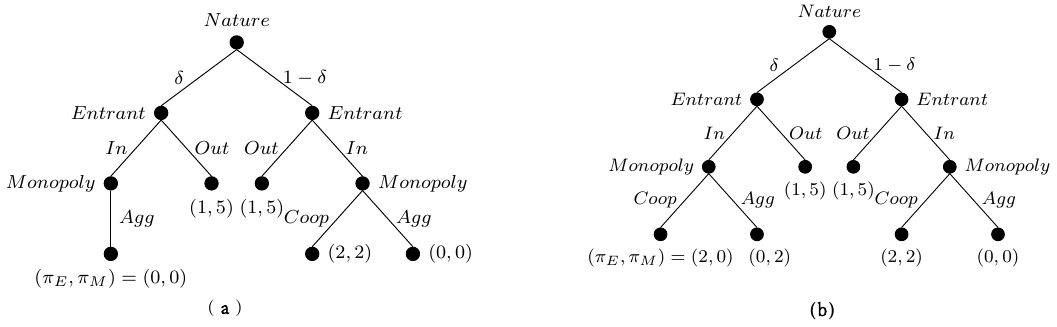
Figure 2. ( a ) Milgrom and Roberts (1982); ( b ) Kreps and Wilson